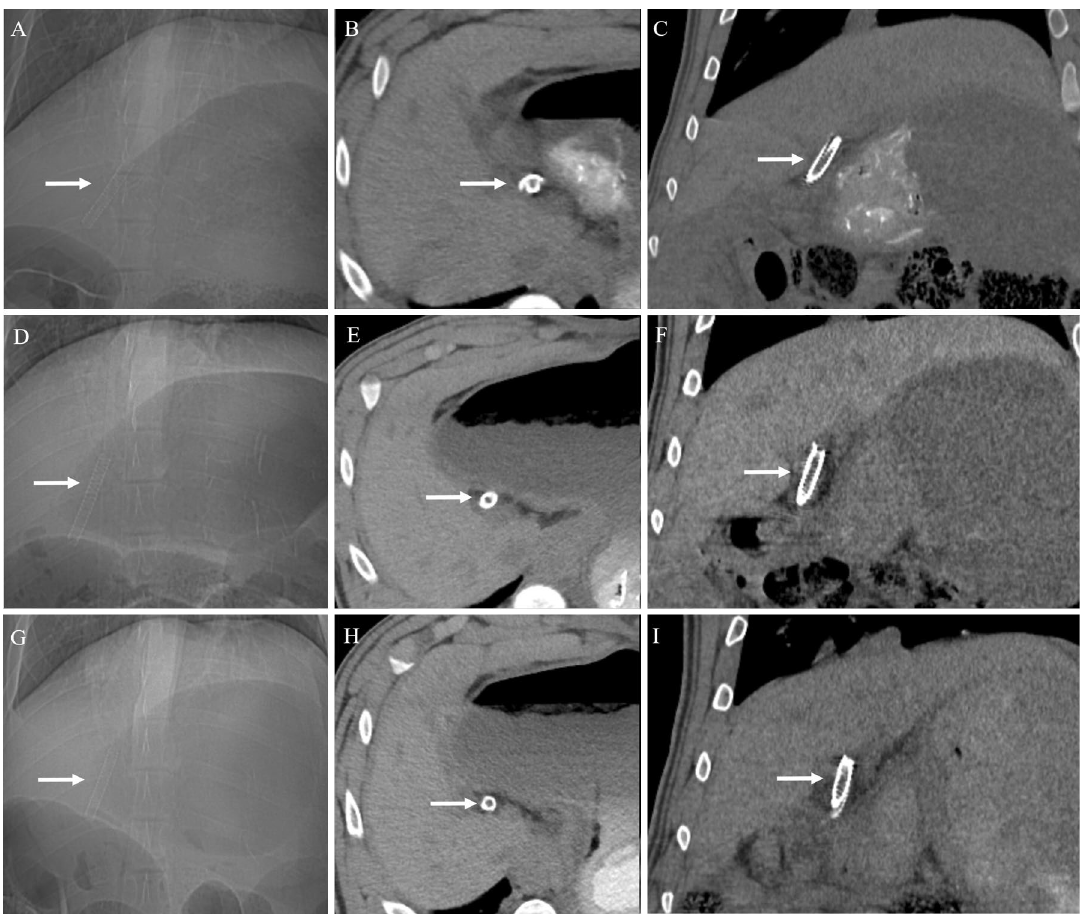
Figure 5. Representative images of 1-month ( A – C ), 2-month ( D – F ), and 3-month ( G – I ) follow-up CT scans to evaluate the status of biodegradable stents. The scout images ( A , D , G ), precontrast axial images ( B , E , H ), and coronal reconstruction images ( C , F , I ) show a radiopaque stent in the common bile duct without